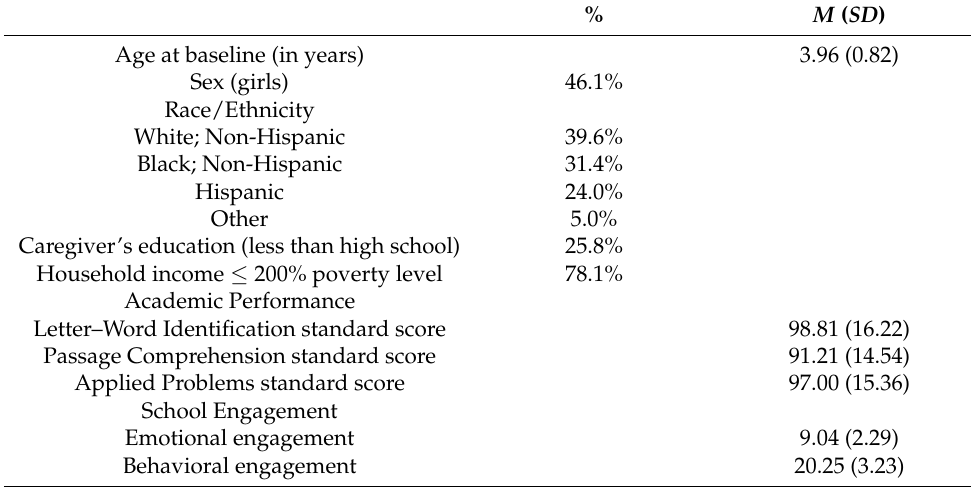
Table 1. Descriptive Statistics for Key Study Variables (N =